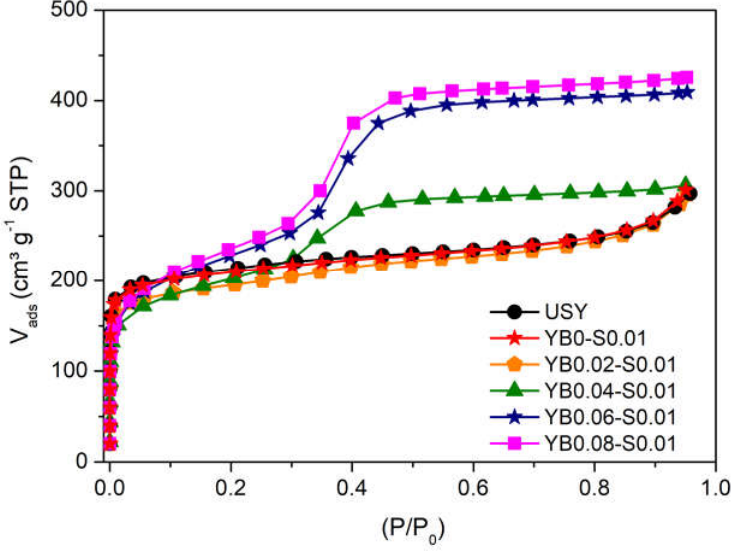
Figure 8. Nitrogen adsorption isotherms of the modified samples produced using different concentrations of the alkaline medium.